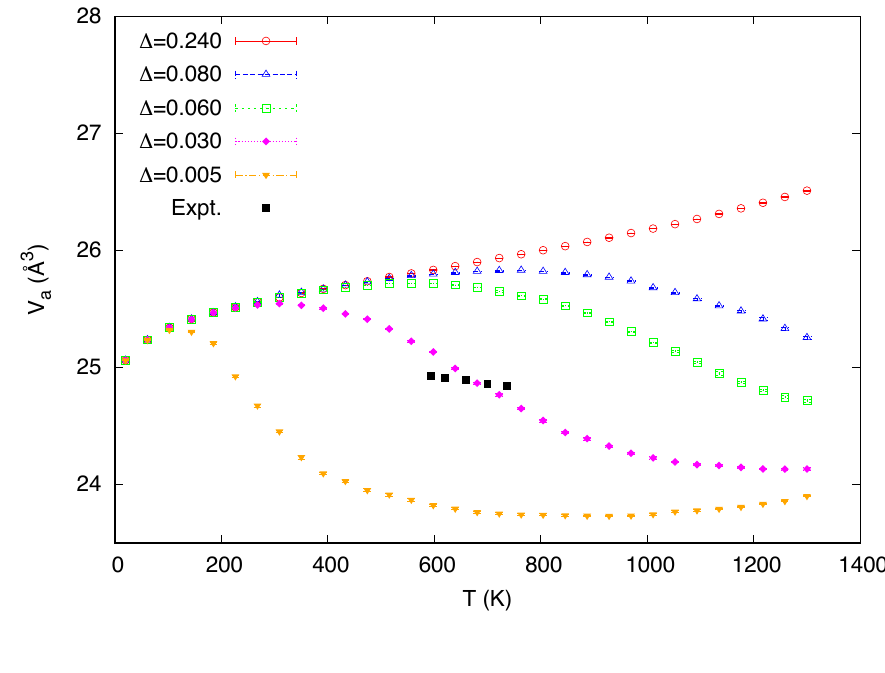
Figure 6. Calculated temperature dependence of the atomic volume for a varying value of the mixing energy ∆ (in eV). The experimental data [48] in the stability range of δ -Pu are also included for